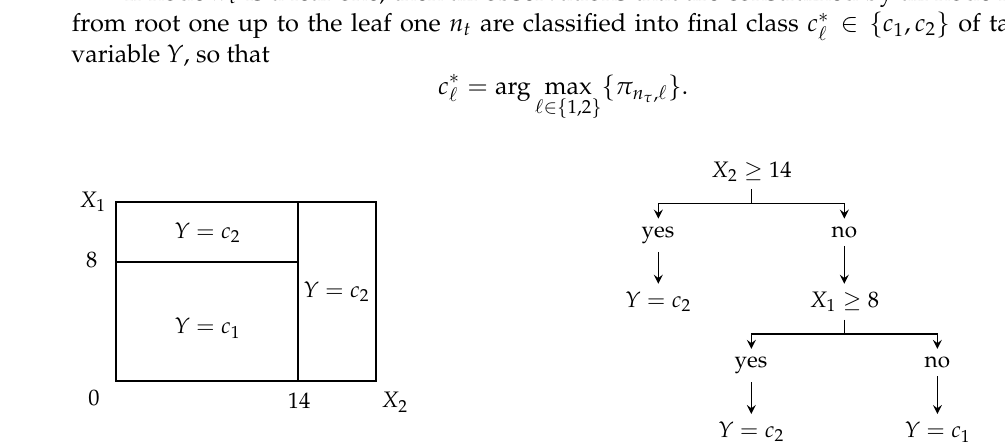
Figure 7. Linear splitting of the variables’ (simplified) space X 1 × X 2 according to the likely distribu- tion of target variable Y ’s classes (on the left) and an appropriate tree representation with two node rules, X 2 ≥ 14 and X 1 ≥ 8 (on the